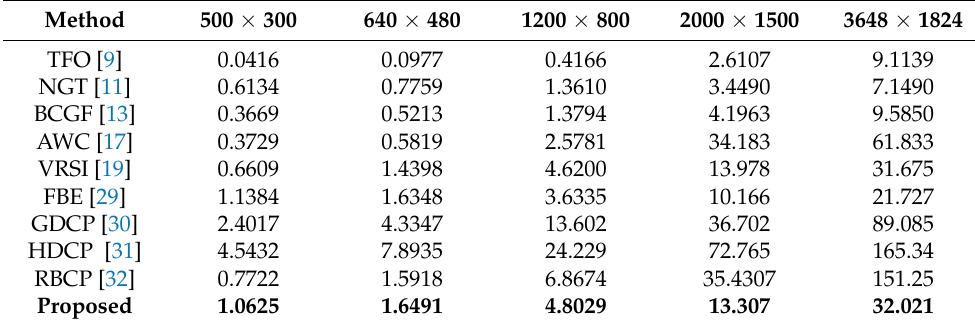
Table 3. The running times of various methods (unit: